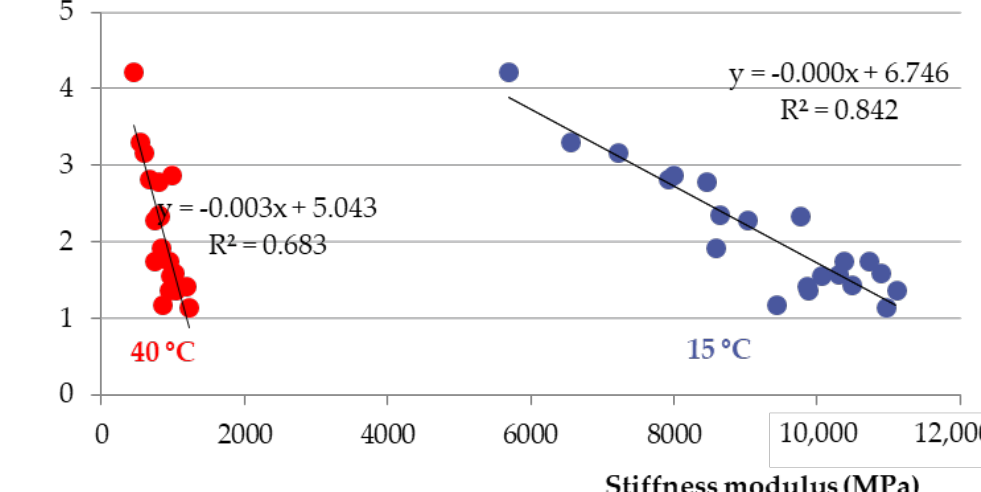
Figure 14. Relationship between stiffness modulus at the test temperatures of 15 °C and 40 °C and absorption of test samples.